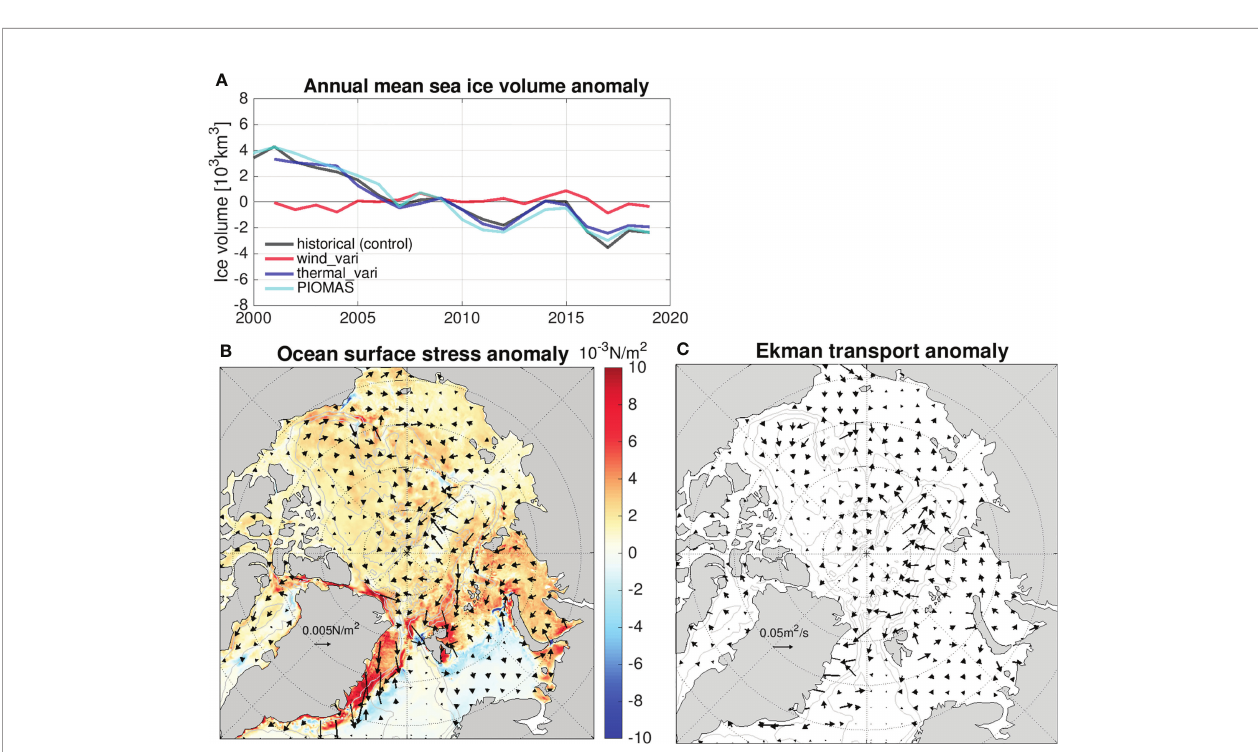
FIGURE 8 | Arctic sea ice decline increases ocean surface stress. (A) Arctic sea ice volume anomaly in different FESOM simulations and in PIOMAS estimate (Schweiger et al., 2011). (B) Difference of ocean surface stress between the historical simulation and wind_vari simulation (the former minus latter) averaged over 2001-2019. The color patch shows the difference of the surface stress magnitude while the arrows indicate the vector difference of the surface stress. (C) The same as (B) , but for surface Ekman